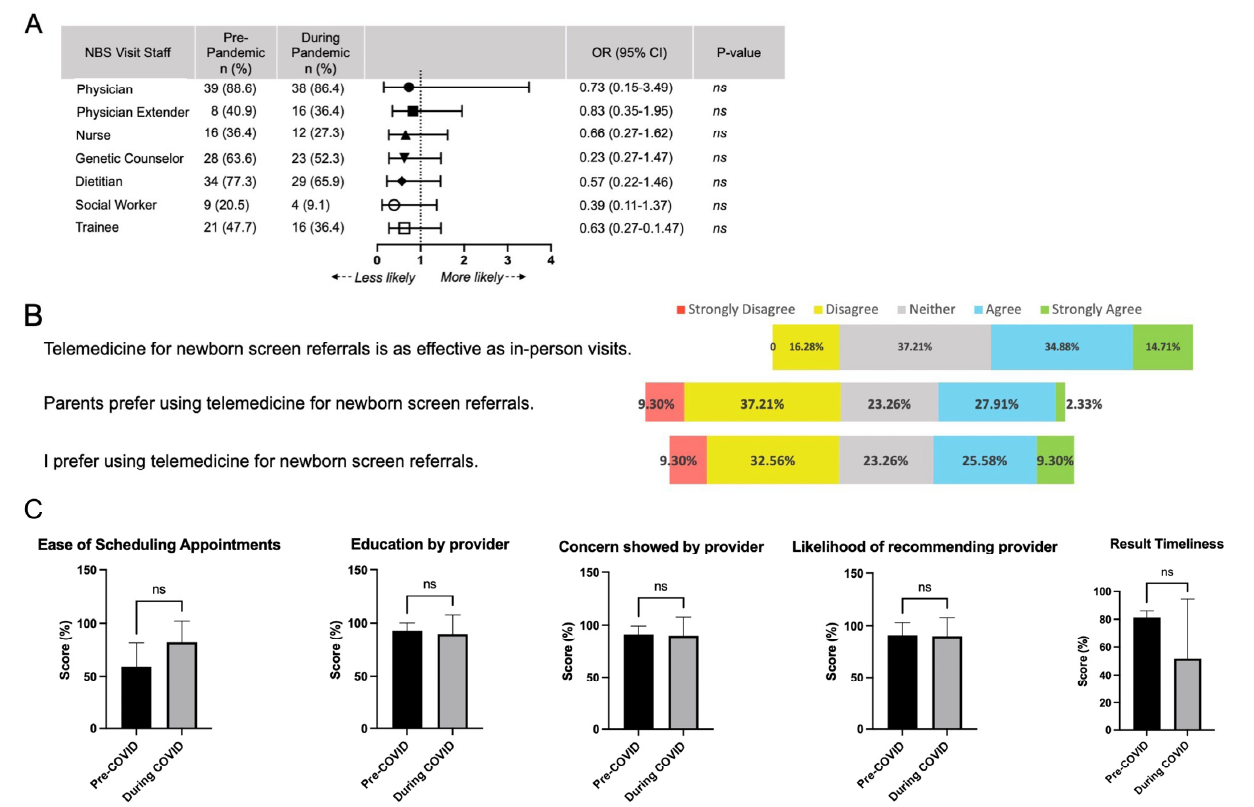
Figure 2. Telehealth for NBS referral is non-inferior to in-person clinic visits. ( A ) Odds ratios were calculated for staffing of NBS referrals prior to and during the pandemic. There was no significant different in staff presence during March-June 2020. ( B ) Provider responses recorded on a 5-point Likert scale regarding opinion on using telehealth during the COVID-19 pandemic. ( C ) Scores on Press Ganey patient surveys showed no difference in appointment logistics, provider communication, provider empathy, likelihood of recommending provider, or timeliness of receiving results. ns: